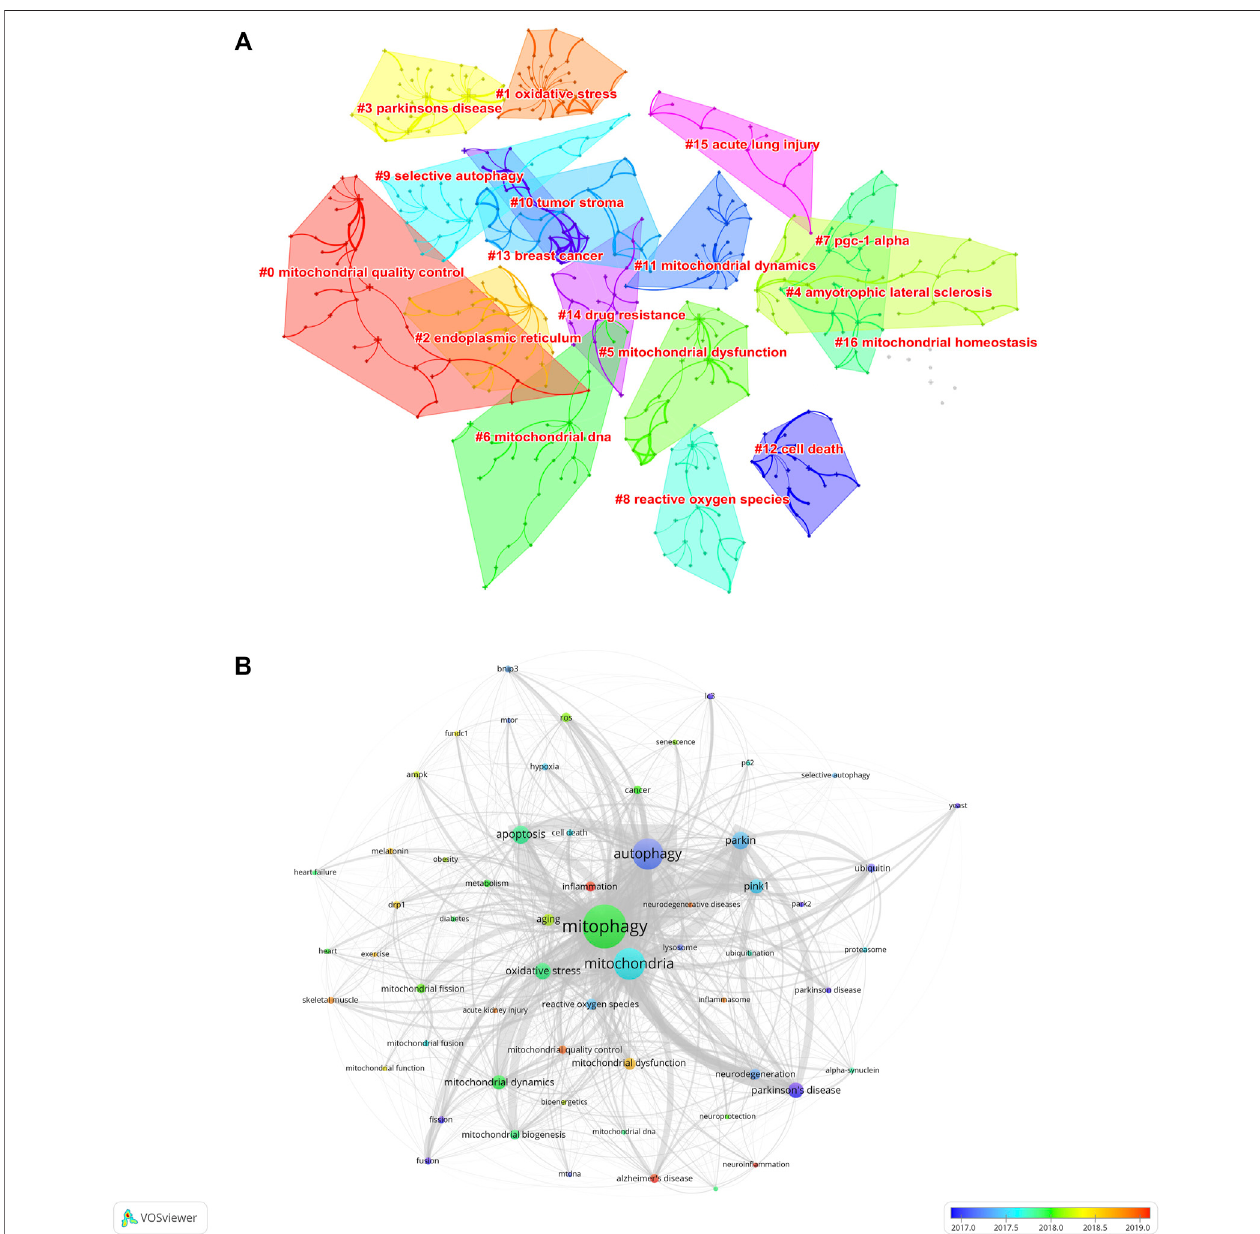
FIGURE 8 | Analysis of keywords of the 5844 articles on mitophagy. (A) Clustering map of author keywords related to the research of mitophagy. (B) Author keyword overlay visualization map. The size of each circle indicates the frequency of occurrences of the author keyword. According to the color label in the lower right corner, the color of each circle indicates the average year when the keyword appeared in articles. The distance between any two circles is indicative of their co- occurrence link, and the thickness of the connecting line indicates the strength of the link.